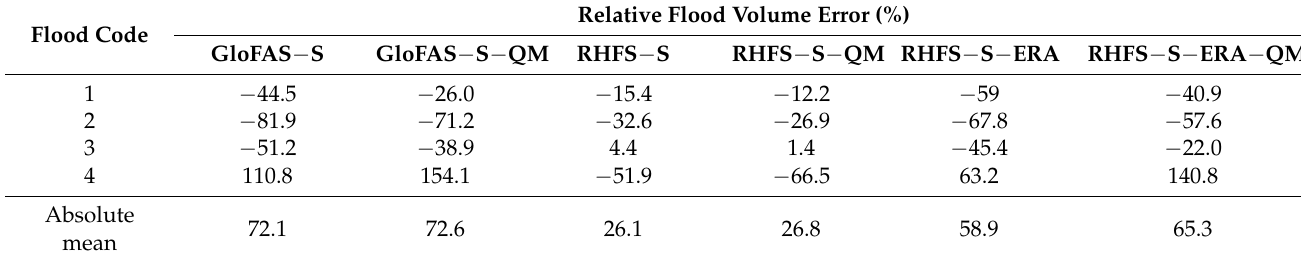
Table 3. Relative flood volume error of simulations for four flood events during the verification period.